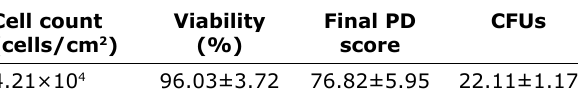
Table-1: Cell counting, viability, final PD and CFUs of rat BMMSCs. Cell count (cells/cm 2 )